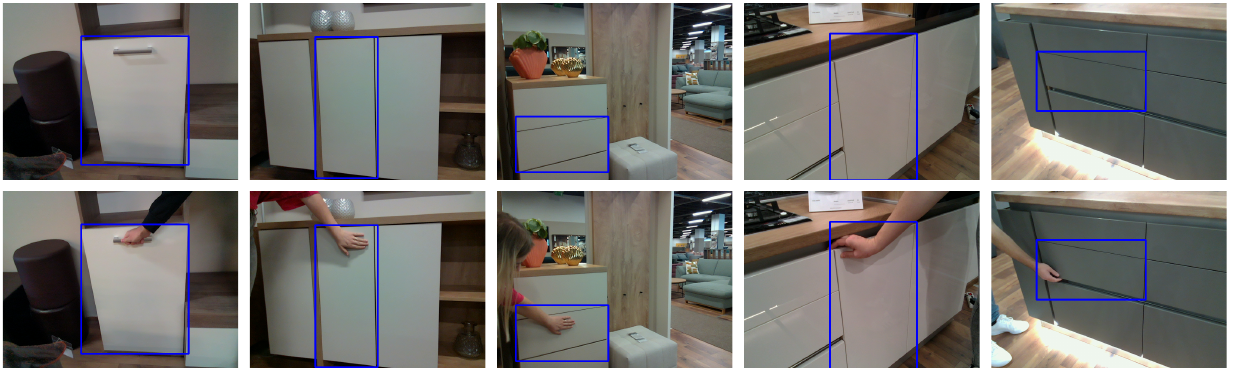
Figure 3. Sample images with annotations for the door of the object. Top row : Images without human demonstration. Bottom row : Corresponding images with human demonstration. The images in the bottom row were captured from the same viewpoint as the top